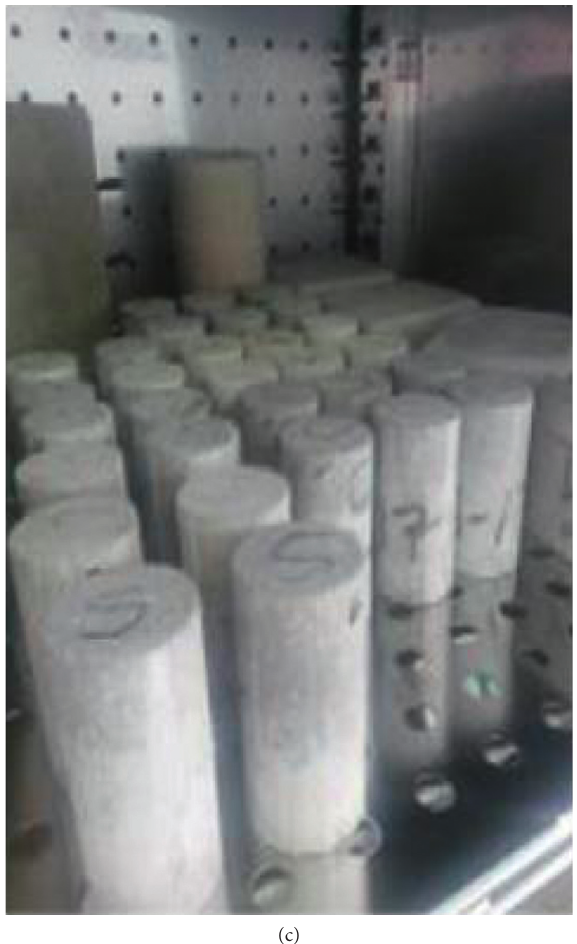
Figure 1: (a) Carbonation chamber; (b) measurement for mass constancy; (c) carbonation chamber with